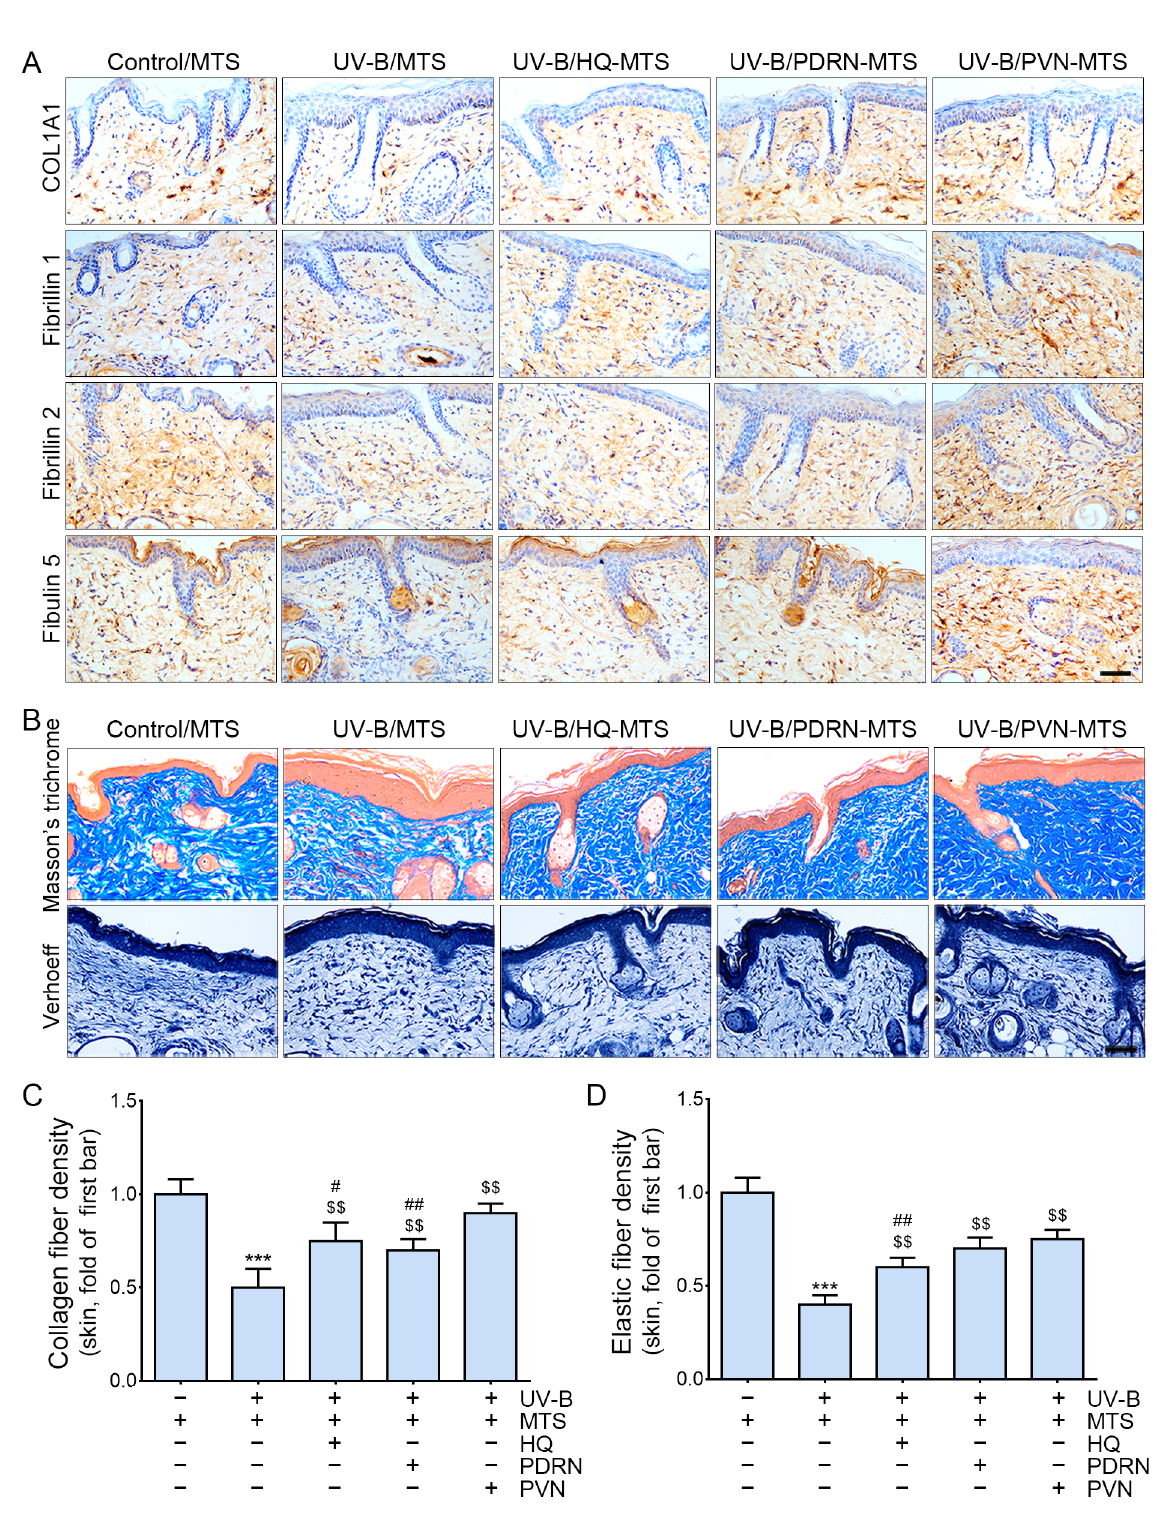
Figure 4. Regulation of the expression of COL1A1, fibrillin 1/2, and fibulin 5 by PVN treatment in UV-B-radiated animal skin. ( A ) COL1A1, fibrillin 1 and 2, and fibulin 5 expression in the UV-B- radiated animal skin was determined by immunohistochemistry (scale bar = 100 µ m). ( B ) Collagen and elastin fibers in the UV-B-radiated animal skin were stained for Masson’s trichrome and